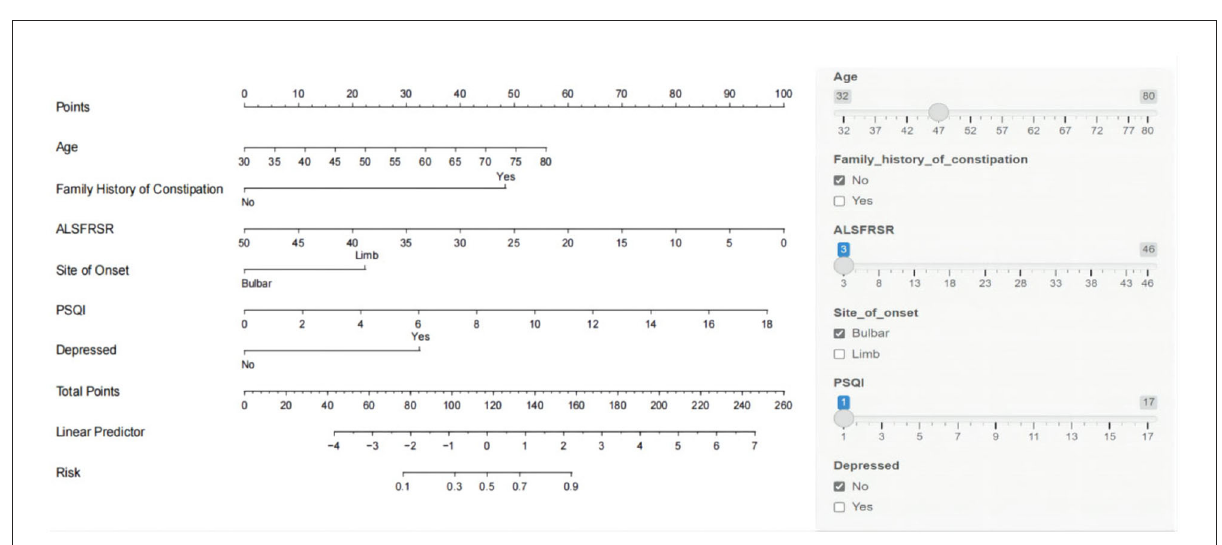
FIGURE3 Nomogram model for predicting the risk of constipation in patients with amyotrophic lateral sclerosis